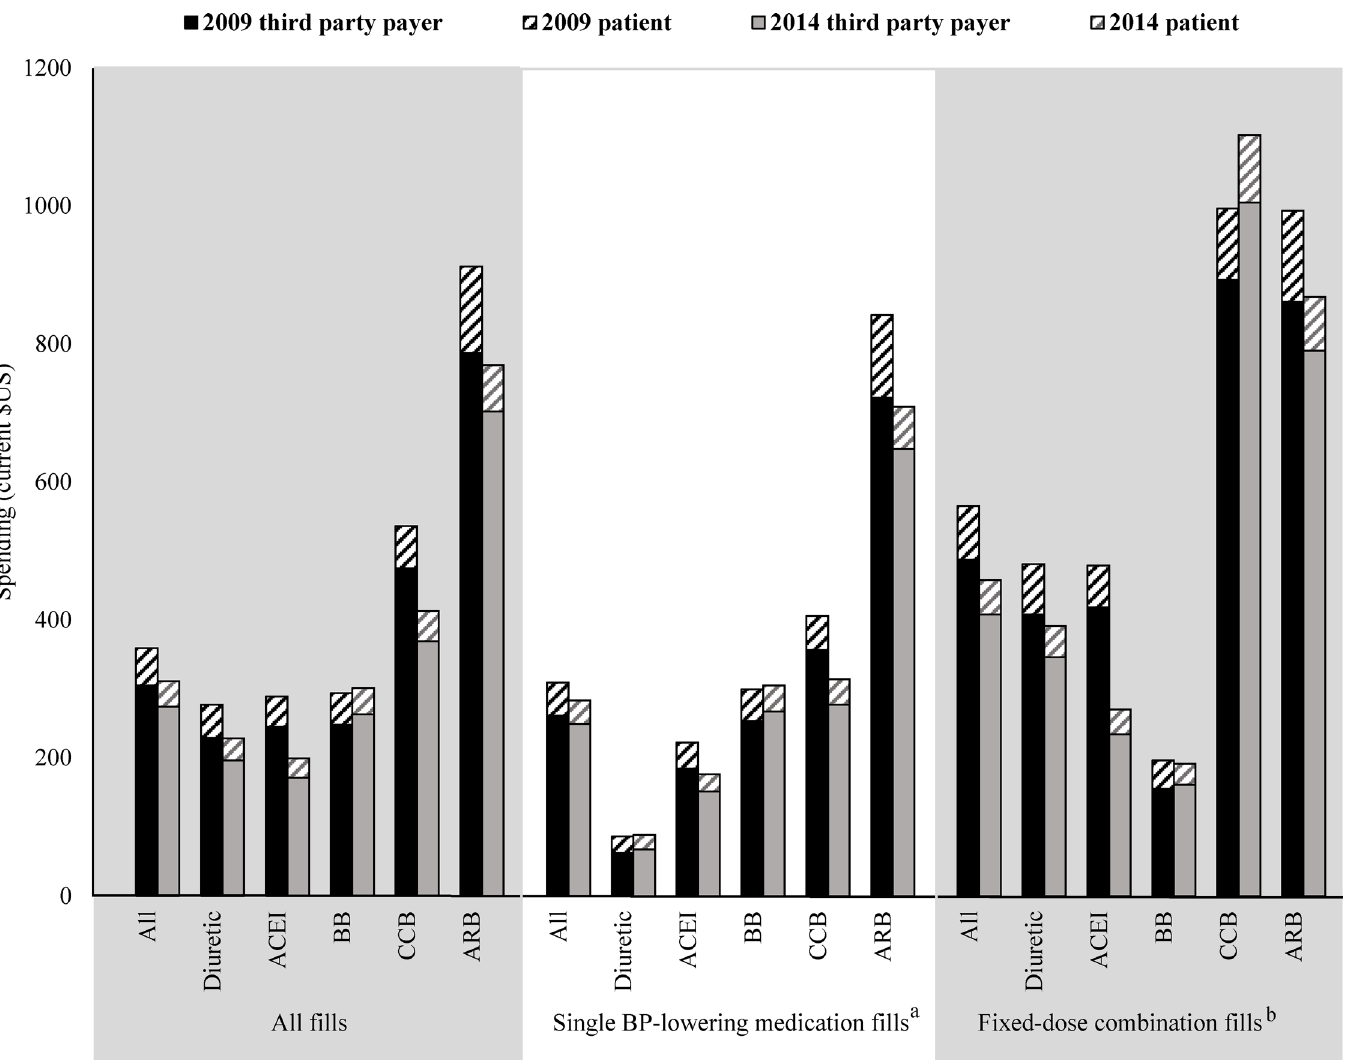
Fig 2. Payment-related Factors that Promote Adherence to Blood Pressure-lowering Medications by Class, 2009 and 2014. ACEI indicates angiotensin converting enzyme inhibitor; BB, beta blocker; BP, blood pressure; CCB, calcium channel blocker; and, ARB, angiotensin II receptor blocker. a Single medication fills contain one active BP-lowering medication ingredient per pill. b Fixed-dose combinations contain more than one active BP-lowering medication ingredient per pill. Source: IMS Health National Prescription Audit, 2009 –